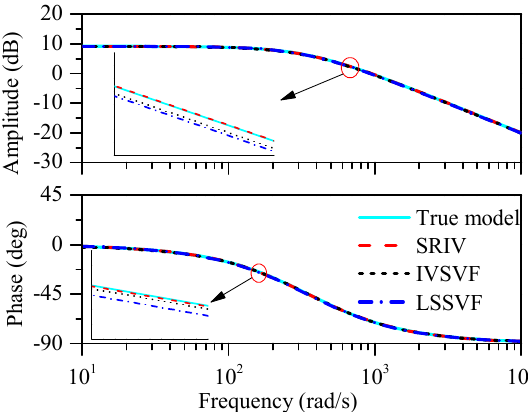
Figure 3. Bode plots of the proposed identification algorithms compared with that of the actual model.